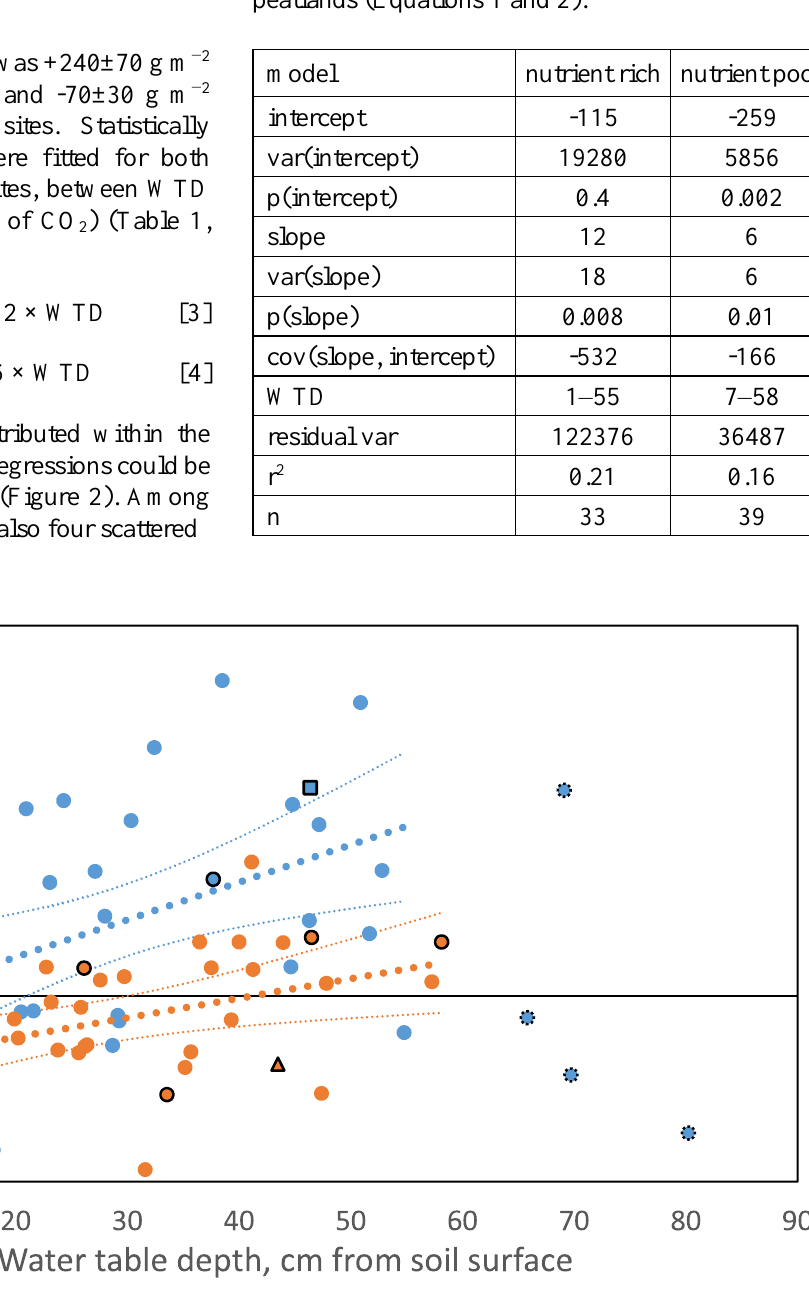
Figure 2. Linear regression, with 95 % confidence band, between mean May–October water table depth and annual soil net CO emissions at nutrient rich (blue) and nutrient poor (orange) forestry-drained boreal 2 peatlands. Data: Ojanen et al . (2013) (no border; those excluded from regression with dotted black border), Ojanen et al . (2019) (black border), Minkkinen et al . (2018) (triangle with black border), Korkiakoski et al . (2018) (square with black border). Positive values indicate emissions and negative values indicate